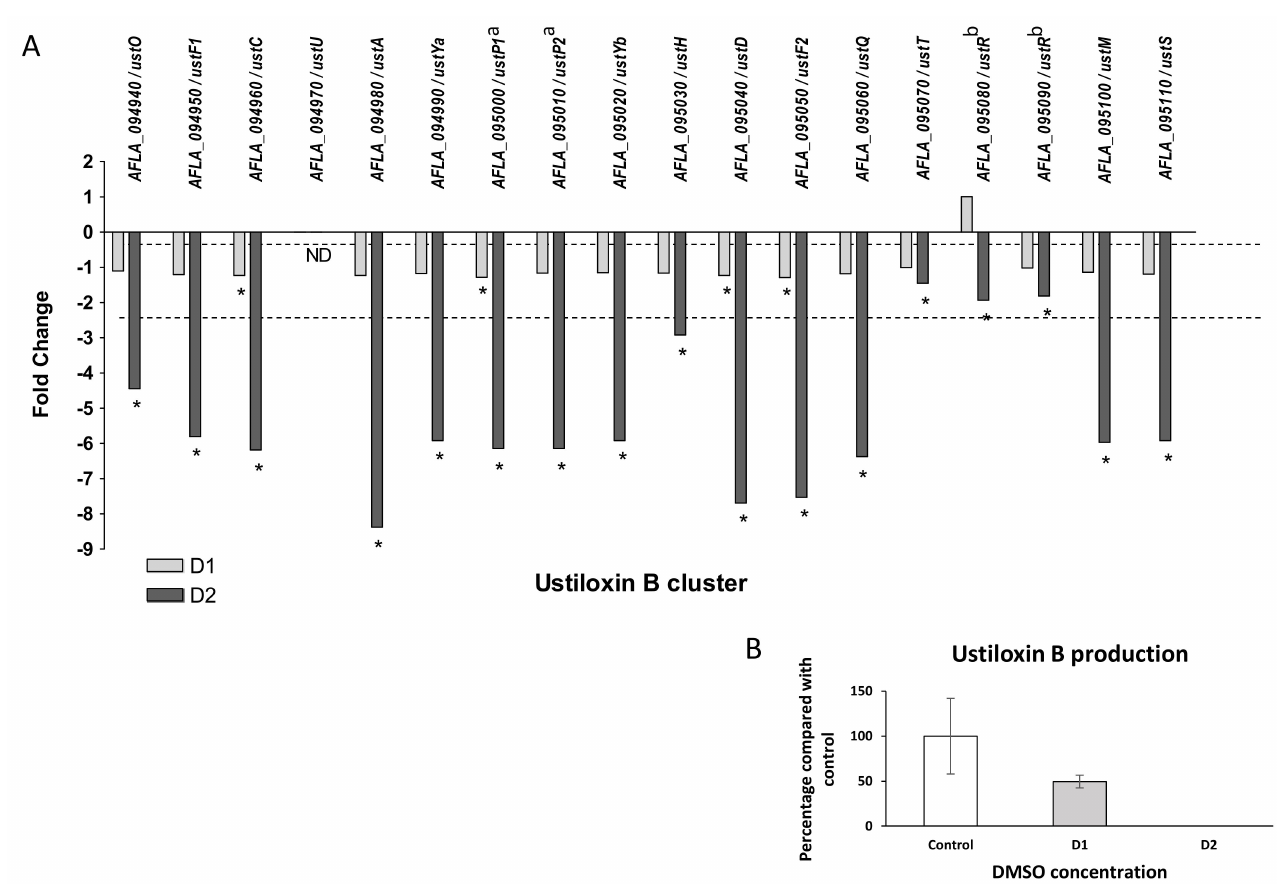
Figure 10. Effect of DMSO treatment on ustiloxin B biosynthesis pathway. ( A ) Fold change expression of genes belonging to the ustiloxin B cluster (#31) in response to DMSO (D1 and D2); * q -value < 0.05; ND = gene not detected; dotted line represents abs(FC) = 1 with no difference in expression against control samples. ( B ) Impact of DMSO on ustiloxin B production of Aspergillus flavus NRRL 62477 after 4 days at 27 ◦ C. Results are expressed as percentage of the control value (+/ − SEM). a AFLA_095000 and AFLA_095010 were concatenated to single gene under the Genbank accession number FAA01143 [53]. b AFLA_095080 and AFLA_095090 were concatenated to single gene under the Genbank accession number FAA01150